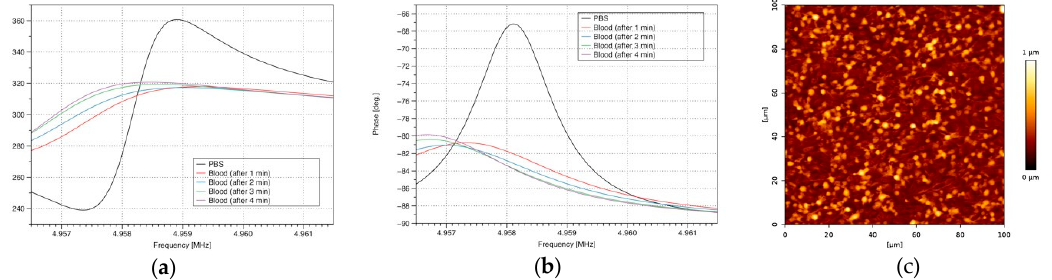
Figure 2. Antibodies functionalized surface Impedance magnitude ( a ) and phase ( b ) response. AFM image of the sensor antibodies bio-functionalized interface with captured platelets ( c ).